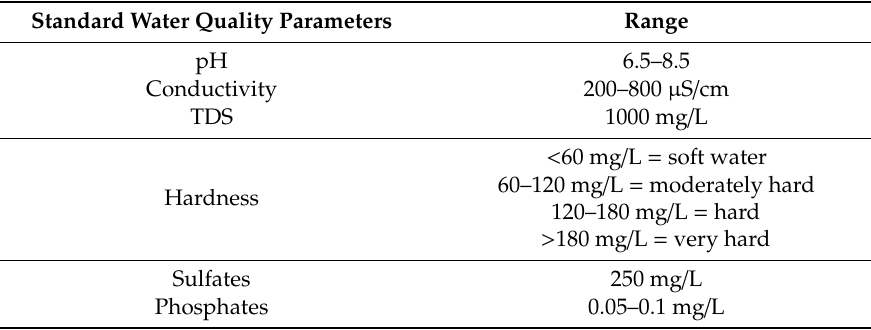
Table 4. Acceptable ranges of standard water quality